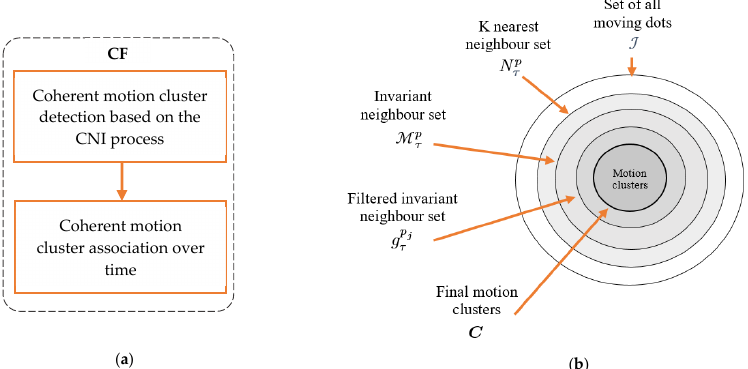
Figure 1. A general illustration of the coherent filtering algorithm (CF) [36]. ( a ) The main sequence processes of CF; ( b ) the process of Coherent Neighbor Invariance (CNI).